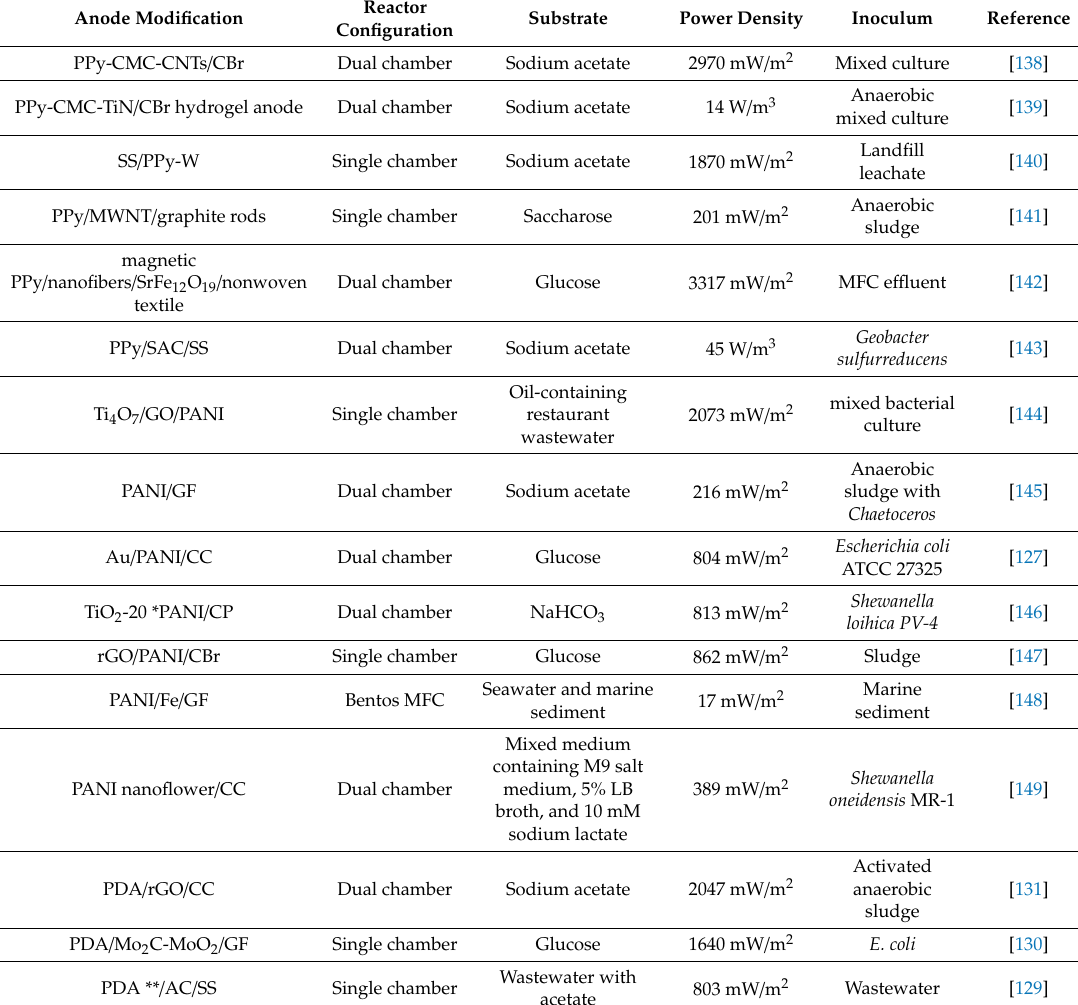
Table 3. Performance of MFCs with anodes modified with